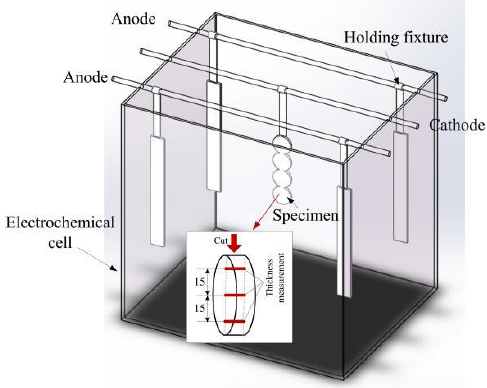
Figure 1. Electrodeposition